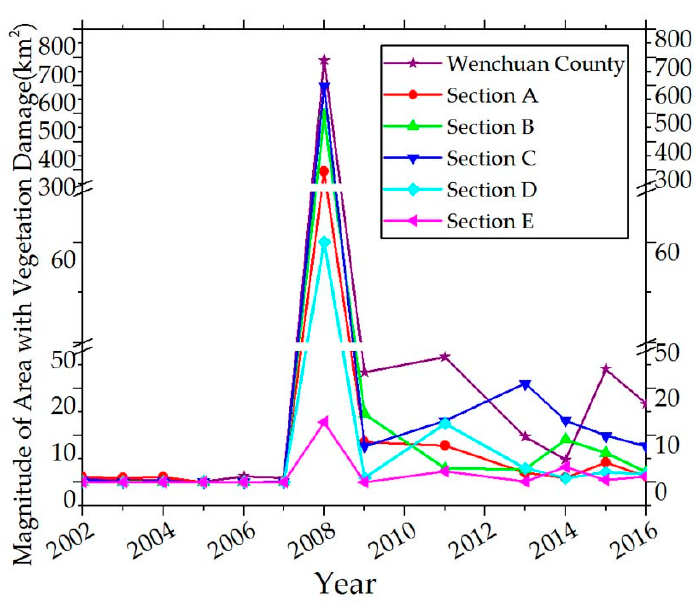
Figure 10. Time series of AVD in Wenchuan County and the five localities from 2002 to 2016.